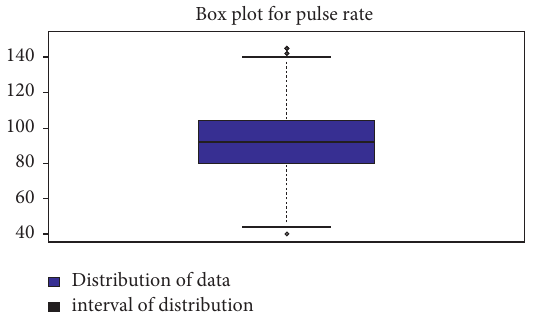
Figure 2: Box plot of the pulse rate for heart failure patients.